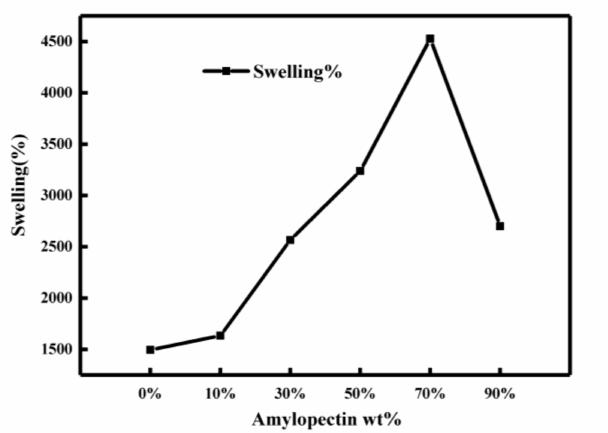
Figure 7. Water swelling diagram of gel